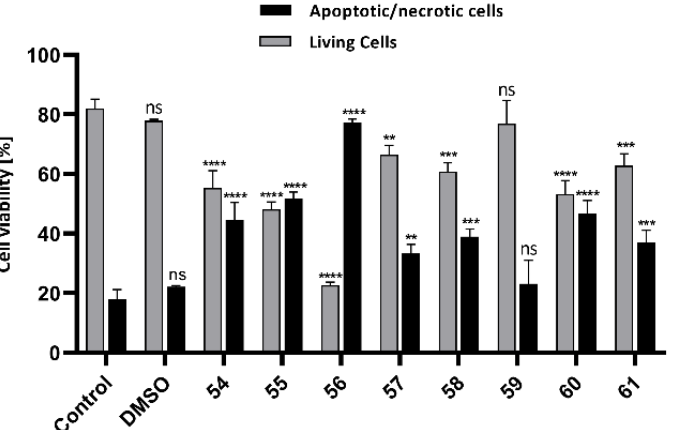
Figure 6. Effect of compounds 54 (5.5 µM), 55 (3.4 µM), 56 (12 µM), 57 (3.1 µM), 58 (3.9 µM), 59 (5.4 (5.4 µ M), 60 (31 µ M), and 61 (4.8 µ M) on cell death in HepG2 cells. The cells were incubated with µM), 60 (31 µM), and 61 (4.8 µM) on cell death in HepG2 cells. The cells were incubated with the tested compounds for 24 h at the concentration corresponding to the total IC 50 values. Quantitative 24 h of treatment. Data are presented as the mean ± SD of three independent experiments. Statistical significance is indicated with asterisks: (ns) p > 0.05, (**) p < 0.01, (***) p < 0.001, and (****) p < 0.0001.